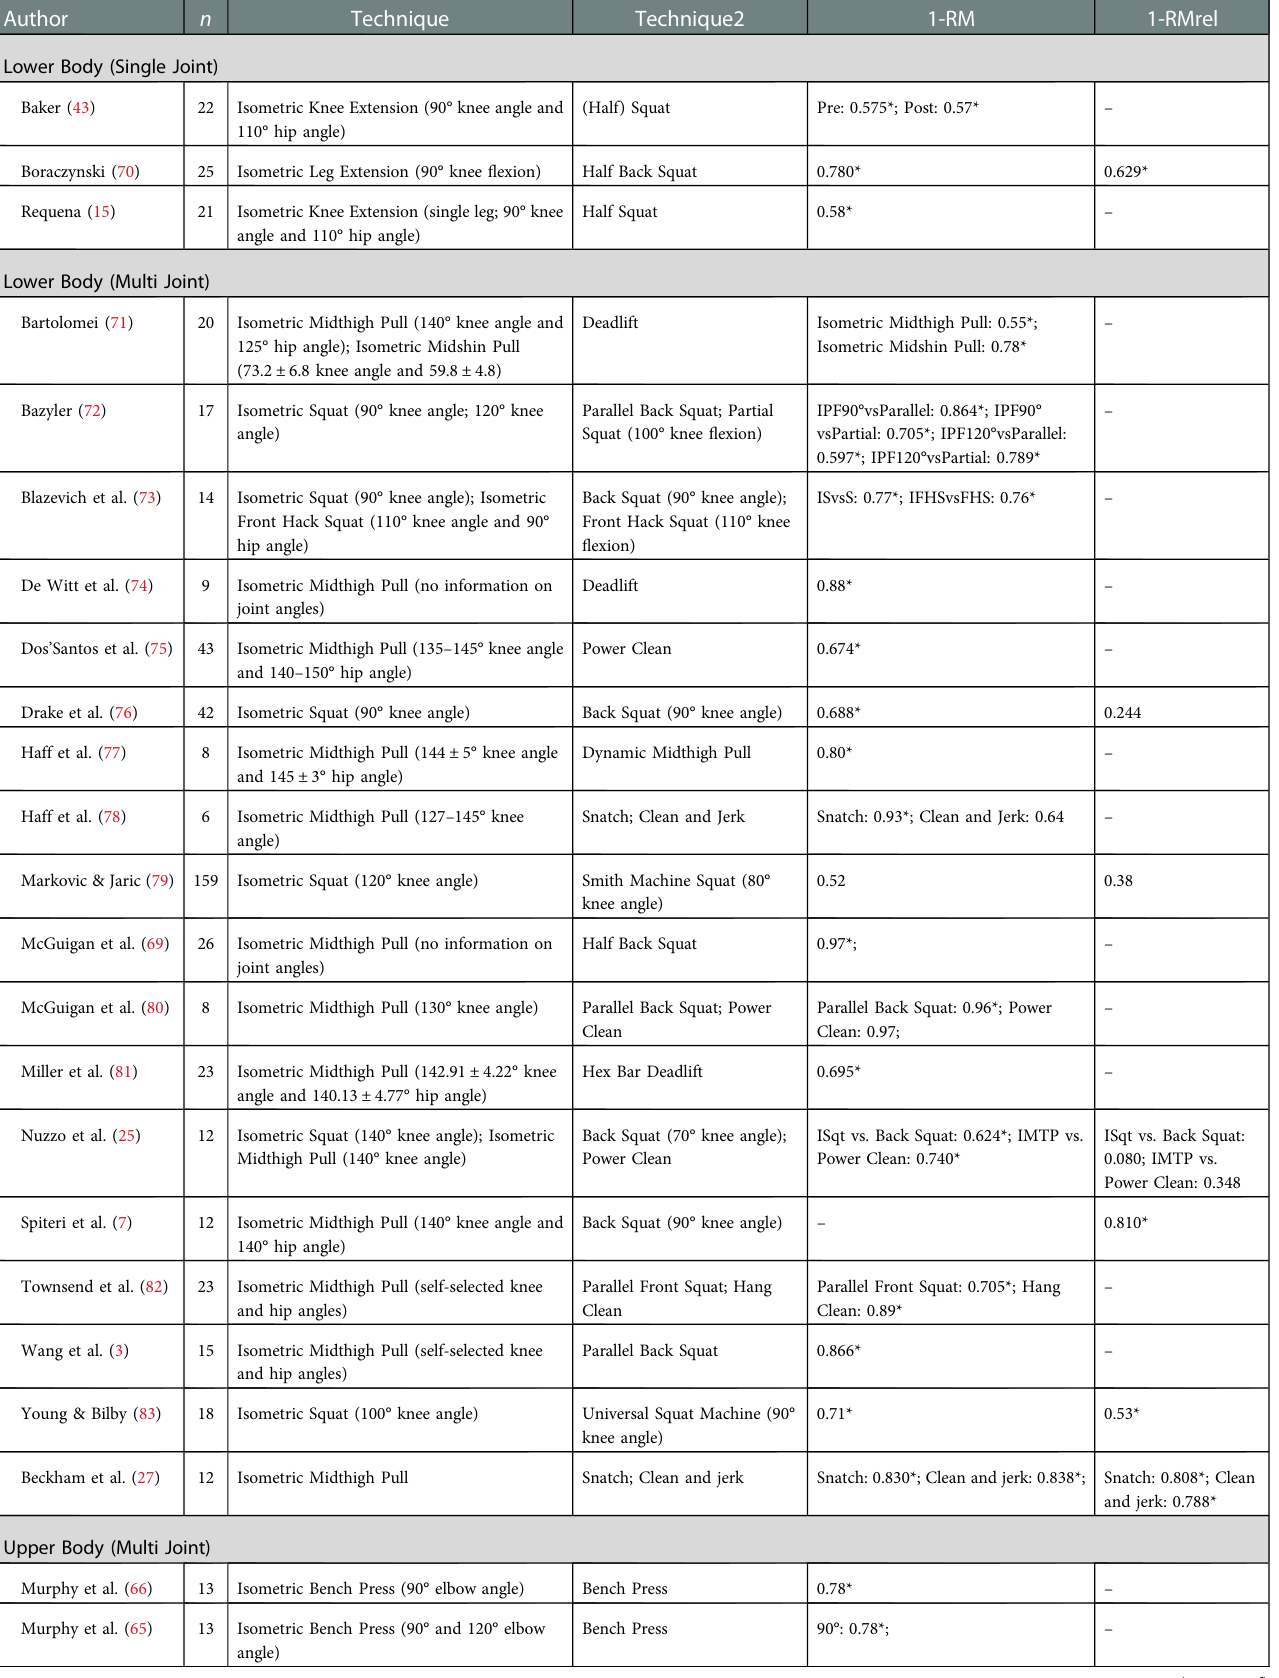
TABLE 1 studies showing signi fi cant correlation coef fi cients between isometric and dynamic strength